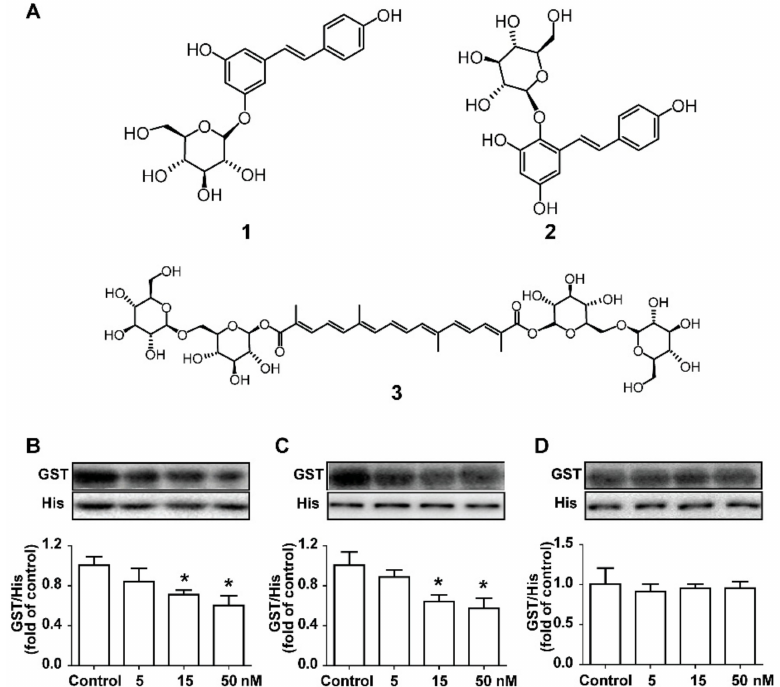
Figure 4. The potential inhibitory effect of the natural compounds on the PCSK9/LDLR interaction. ( A ) Chemical structures of compounds 1 – 3 , namely polydatin, tetrahydroxydiphenylethylene-2- O -glucoside and crocin I, respectively; ( B – D ) The potential inhibition of compounds 1 – 3 on the PCSK9/LDLR interaction were evaluated by the methods above. The GST/His ratios were monitored by western blot assay in the presence of compounds 1 – 3 at different concentrations (5, 15, and 50 nM), respectively. The values are the mean ± SEM deviation of the three independent experiments. * p < 0.05; ** p < 0.01, compared with the control